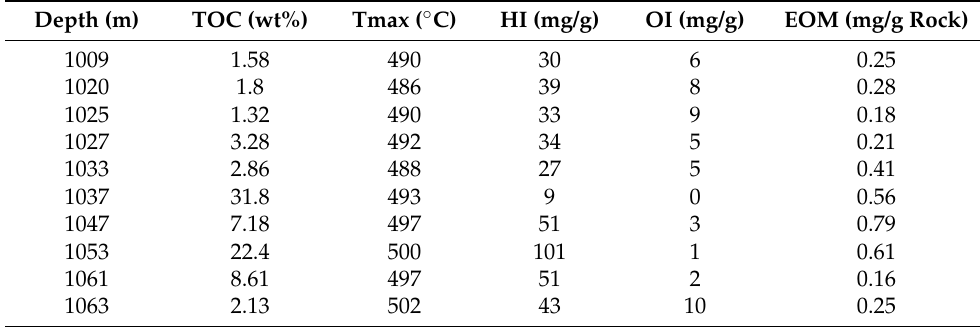
Table 2. Results of Rock-Eval pyrolysis and Soxhlet extraction of Chaiye 2 rock